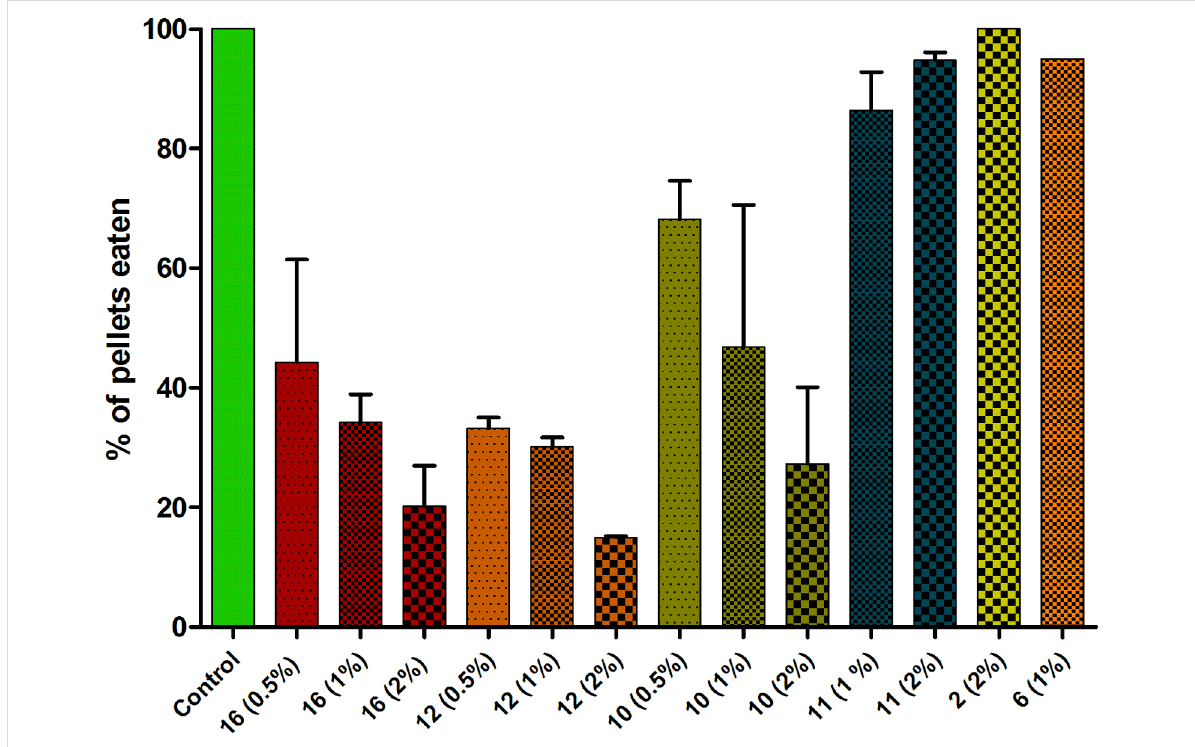
Figure 11: Effect of Phyllodesmium metabolites in different concentrations on predation by Canthigaster solandri ( n = 8–40, depending on availability). Experiments were repeated twice with compounds 10–12 in all tested concentrations, twice with 16 at 1% and 2% and three times at 0.5%. Mean values with SD are displayed. Significance of deterrence was shown with Fisher´s exact test (P < 0.05 for 10 , 12 and 16 , calculated for each trial separately). Control pellets were 100% eaten for each